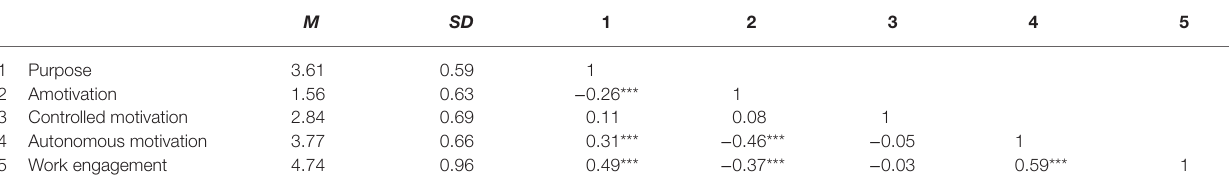
TABLE 2 | Means ( M ), standard deviations ( SD ), and bivariate correlations ( r ). M SD 1 2